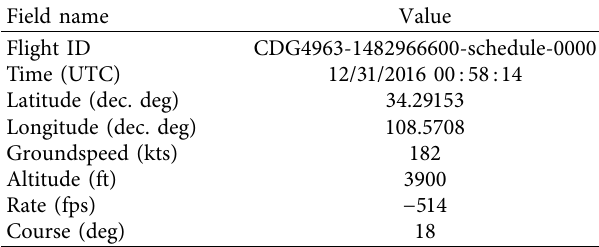
Table 3: One row sample of 4D trajectory